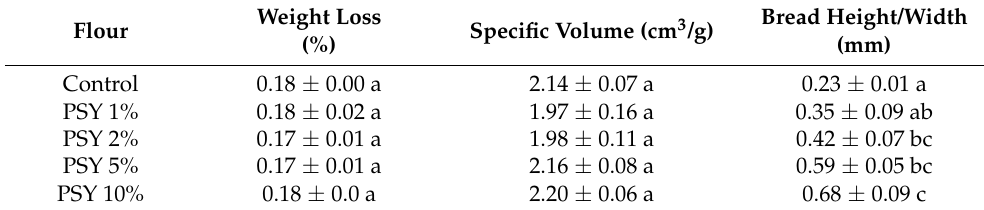
Table 1. Control and psyllium added whole bread dimensions.